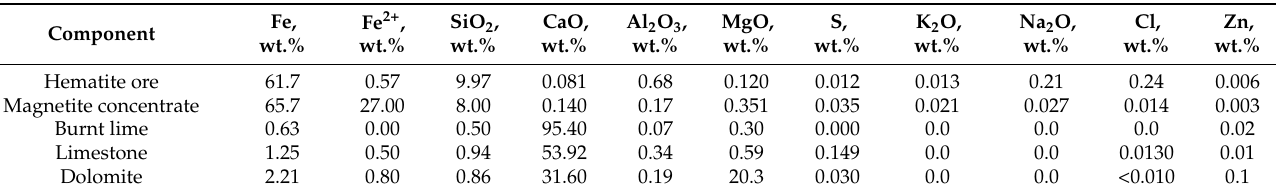
Table 3. Final properties of the sintering mixtures used in the